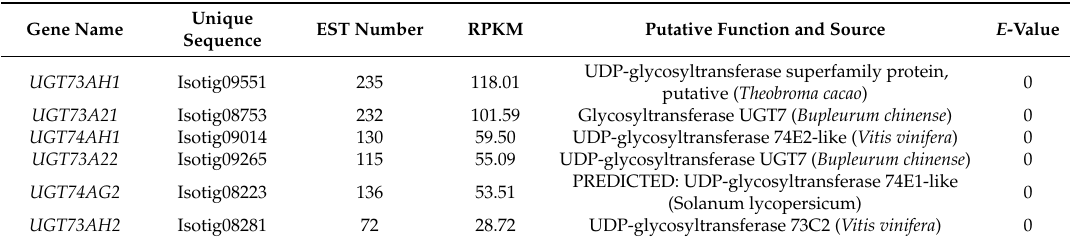
Figure 2 . Phylogenetic analysis of UGTs from C. asiatica and other plant species. Sequences of UGTs associated with triterpene saponin biosynthesis were retrieved from the NCBI database: MtUGT71G1 (AAW56092), PgUGT71A27 (KM491309), BvUGT73C10 (AFN26666), BvUGT73C11 (AFN26667), MtUGT73K1 (AAW56091), MtUGT73F3 (ACT34898), GmUGT73F2 (BAM29362), GmUGT73F4 (29363), GmUGT73P2 (BAI99584), GuUGAT (KT759000), SvUGT74M1 (ABK76266), PgUGT74AE2 (JX898529), SvUGT91H4 (BAI99585), and PgUGT94Q2 (JX898530). Table 2. Selected UGT ( UDP -glucosyltransferase) gene candidates resulting from transcriptome analysis of MeJA-elicited C. asiatica leaves.